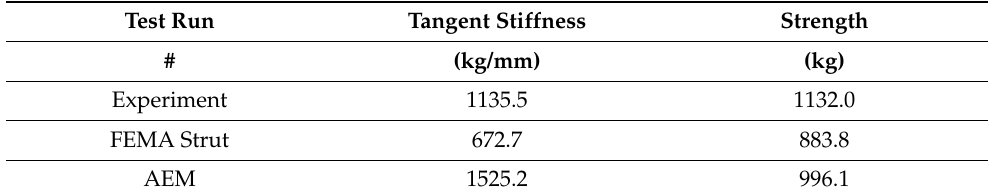
Table 4. Reported results of Pushover Curves for scaled Confined Wall Structure.